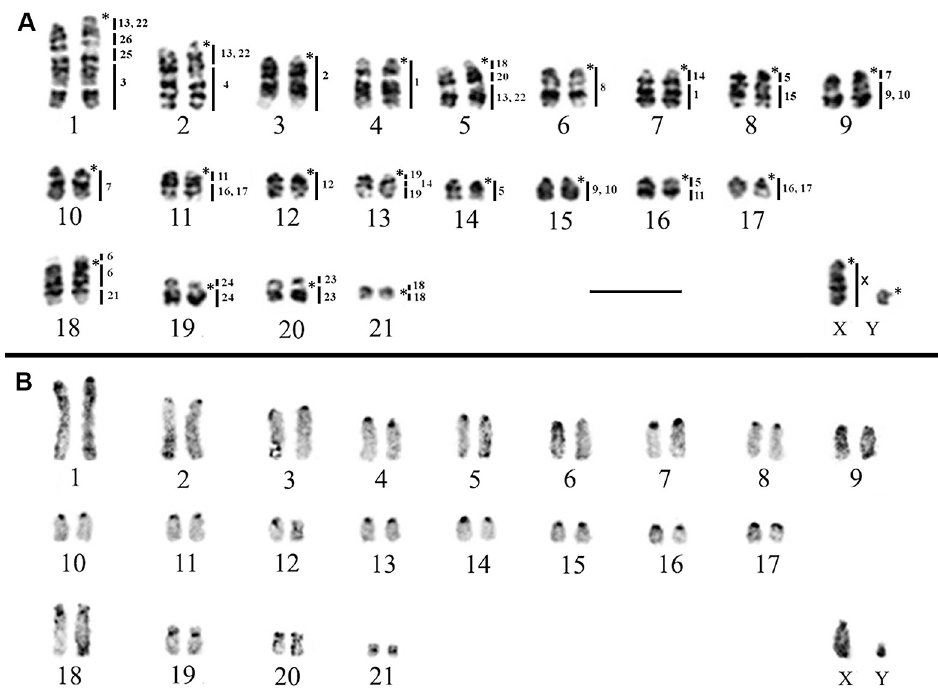
Fig 2. Karyotype of R . emiliae (2n = 44, FN = 50). A) G-banding with genomic mapping using whole chromosome probes of H . megacephalus . B) C-banding showing the locations of constitutive heterochromatin. ( � ) Indicates centromere. Bar: 10 μ